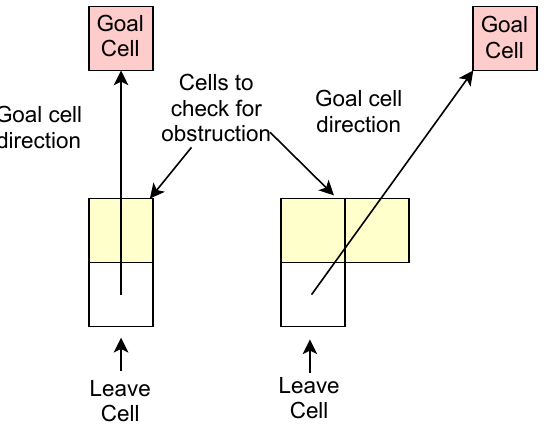
Figure 6. Finding suitable leave point. Leave point is established if cell on A* path has immediate unobstructed cells in original goal direction and is closer to it than path via bypass goal.